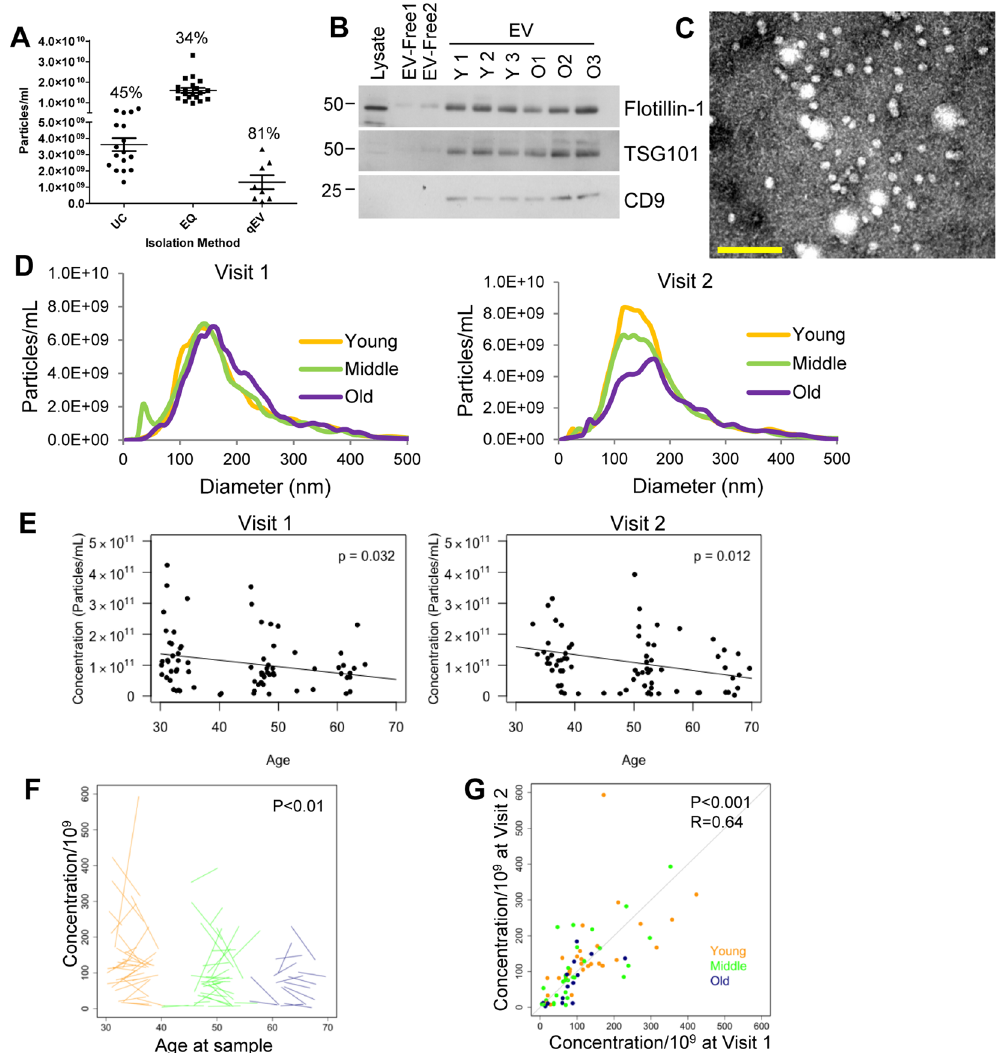
Figure 1. Plasma EV Concentration decreases with human age. ( A ) Comparision of different EV isolation techniques. The same plasma sample was divided into 46 equal aliquots of 200 μ l and EVs were isolated by different methods. Samples were isolated by ultracentrifugation (UC, n = 17), ExoQuick (EQ, n = 20) and size exclusion chromotography (qEV, n = 9). Particle concentration was quantifed by NTA and the coefficient of variance was calculated and indicated for each group. ( B ) Plasma EV samples (5 μ g) from three young (Y1- Y3), three old (O1–O3) individuals, two EV-depleted plasma fractions (EV-free) from subjects Y1 and O1, and neuronal cell lysate were lysed and analyzed by SDS-PAGE followed by immunoblotting with antibodies against the indicated EV markers. The experiment was repeated four times. ( C ) EVs of typical morphology and size range of 50 to 200 nm were observed by electron microscopy. Scale bar = 200 nm ( D ) NTA was used to determine the size distribution of plasma EVs. Each sample was averaged for the young (n = 30), middle aged (n = 30), and old (n = 14) groups for both time points. ( E ) NTA was used to determine the EV plasma concentration for each individual of the 74 participants in cross-sectional analyses of the two different time points. P value was determined by linear mixed-model regression. ( F ) The changes in concentration overtime are represented by a spaghetti plot where the start of each line represents the starting EV plasma concentration and the end of the line represents the concentration at the last time point. ( G ) The concentration at time point 1 and time point 2, are plotted on the x and y axis. The similarity between an individual’s EV concentrations at the two time points were analyzed by Pearson